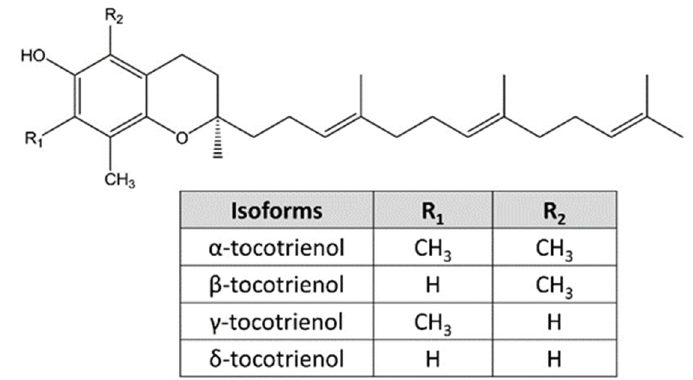
Figure 2. Four isoforms of tocotrienol and their chemical structures.